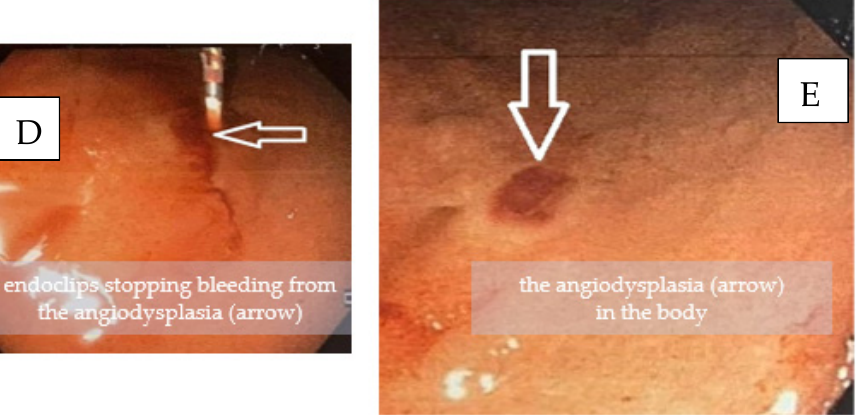
Figure 1. Gastroscopy images. ( A )—blood between the folds of the stomach; ( B , D )—endoclips; ( C , E )—angiodysplasias of the body.